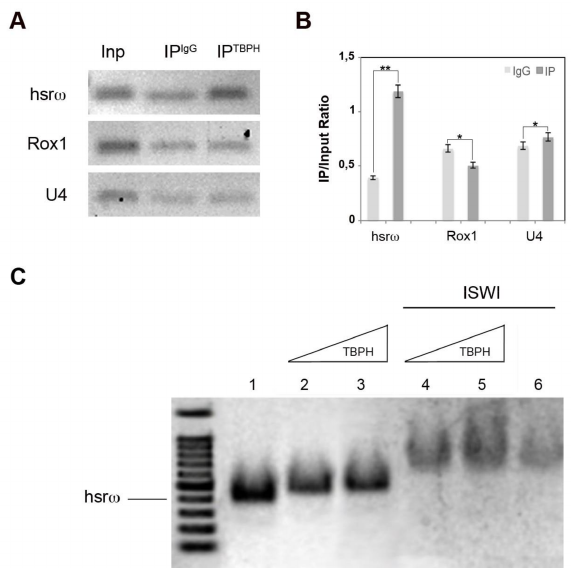
Figure 3. TBPH physically and functionally interacts with the hsr ω ncRNA in vitro. ( A ) Cross-linking RNA-immuno-precipitation (CLIP-RIP) assay was carried out with affinity purified anti-TBPH antibody on fixed larval nuclear extracts from the brain. The immunoprecipitate was analyzed by real-time polymerase chain reaction (RT-PCR) using primers for the 280 bp tandem repeat unit of the nuclear hsr ω ncRNA; primers amplifying the U4 and Rox1 ncRNAs were used as specificity controls. Inp = input, IP TBPH = immunoprecipitated material from anti-TBPH CLIP, IP IgG = immunoprecipitated material from IgG CLIP; ( B ) The intensity of PCR signals was quantified using ImageJ. The experiment was performed considering five biological replicates. The error bars show the standard deviation. Unpaired Student’s t -test was performed to assay statistical significance; * 0.01 ≤ p -value ≤ 0.05; ** p -value < 0.01; ( C ) TBPH hnRNP binds α 32 P labeled hsr ω -n arcRNA in electrophoresis shift mobility assay (EMSA). ISWI modulates the TBPH-hsr ω interaction, as shown by changes in the gel shift. Binding reactions were performed at different stoichiometric ratios for hsr- ω /TBPH: 1:2 (lanes 2 and 4), 1:50 (lanes 3 and 5) and constant ratio for hsr- ω /ISWI: 1:20 (lanes 4, 5, and 6). Lane 1 shows the α 32 P hsr ω -n probe